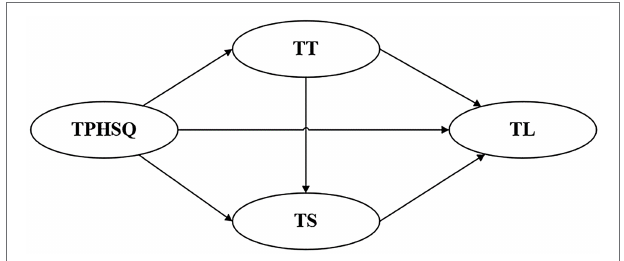
FIGURE 1 | Proposed model. TPHSQ, tourism public health service quality; TT, tourist trust; TS, tourist satisfaction; and TL, tourist loyalty.